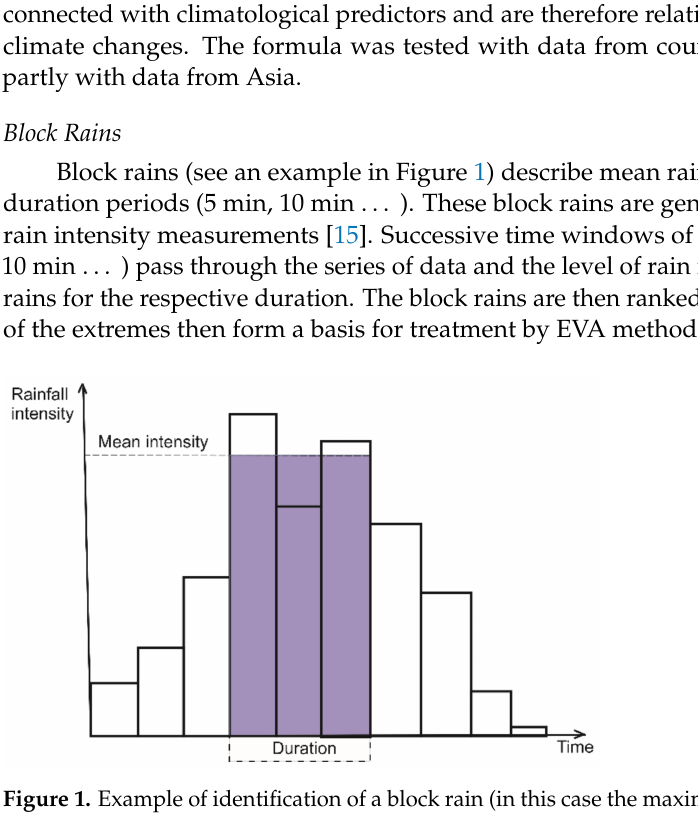
Figure 1. Example of identification of a block rain (in this case the maximum block rain) in a recorded rainfall